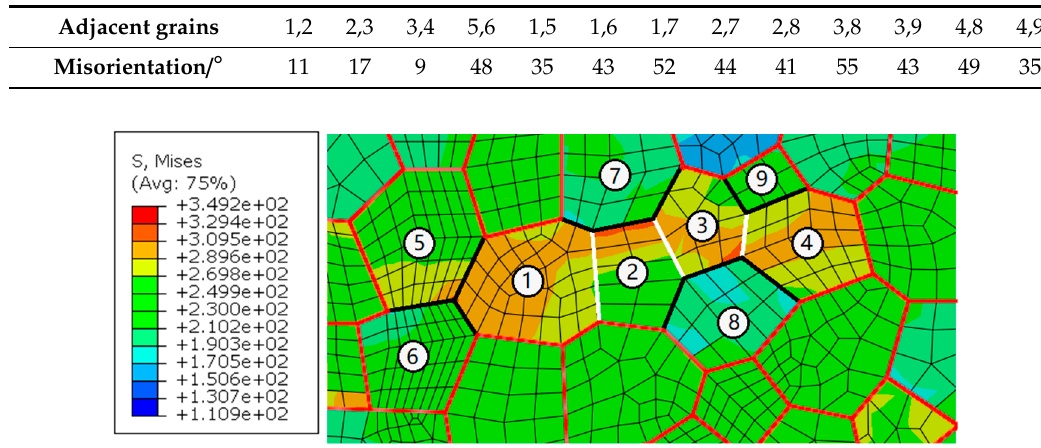
Table 3. Misorientations of adjacent grains in Figure 13.